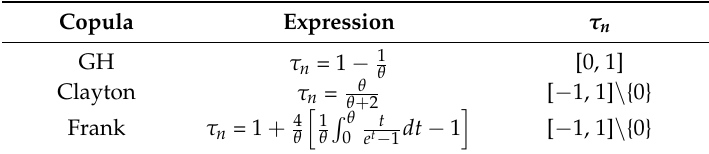
Table 3. The relationship of the parameter of Archimedean Copula and Kendall τ n